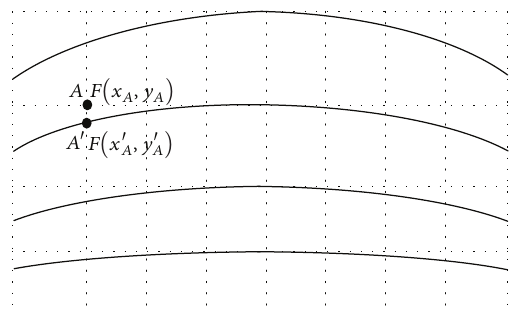
Figure 14: Illustration of correction for the distorted image.